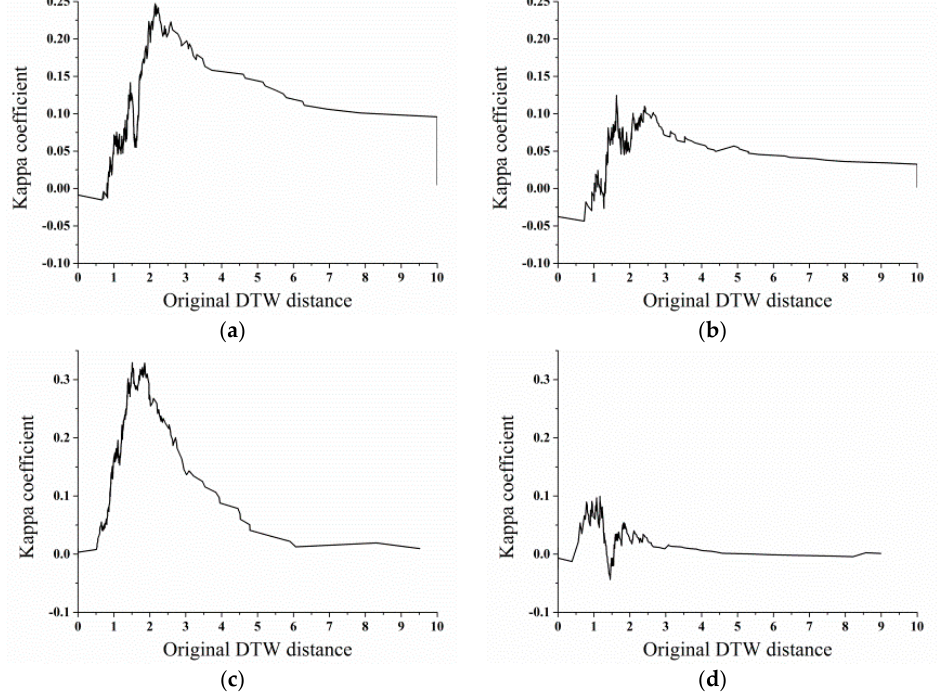
Figure 5. Relationship between the threshold values of the original DTW distance with the kappa coefficient. This step obtains the optimal threshold to extract crop types. The pattern is obtained by 300 randomly generated points: ( a ) is the rice paddy in test site 1; ( b ) is the dryland crop in test site 1; ( c ) is the rice paddy in test site 2; and ( d ) is the dryland crop in test site 2.